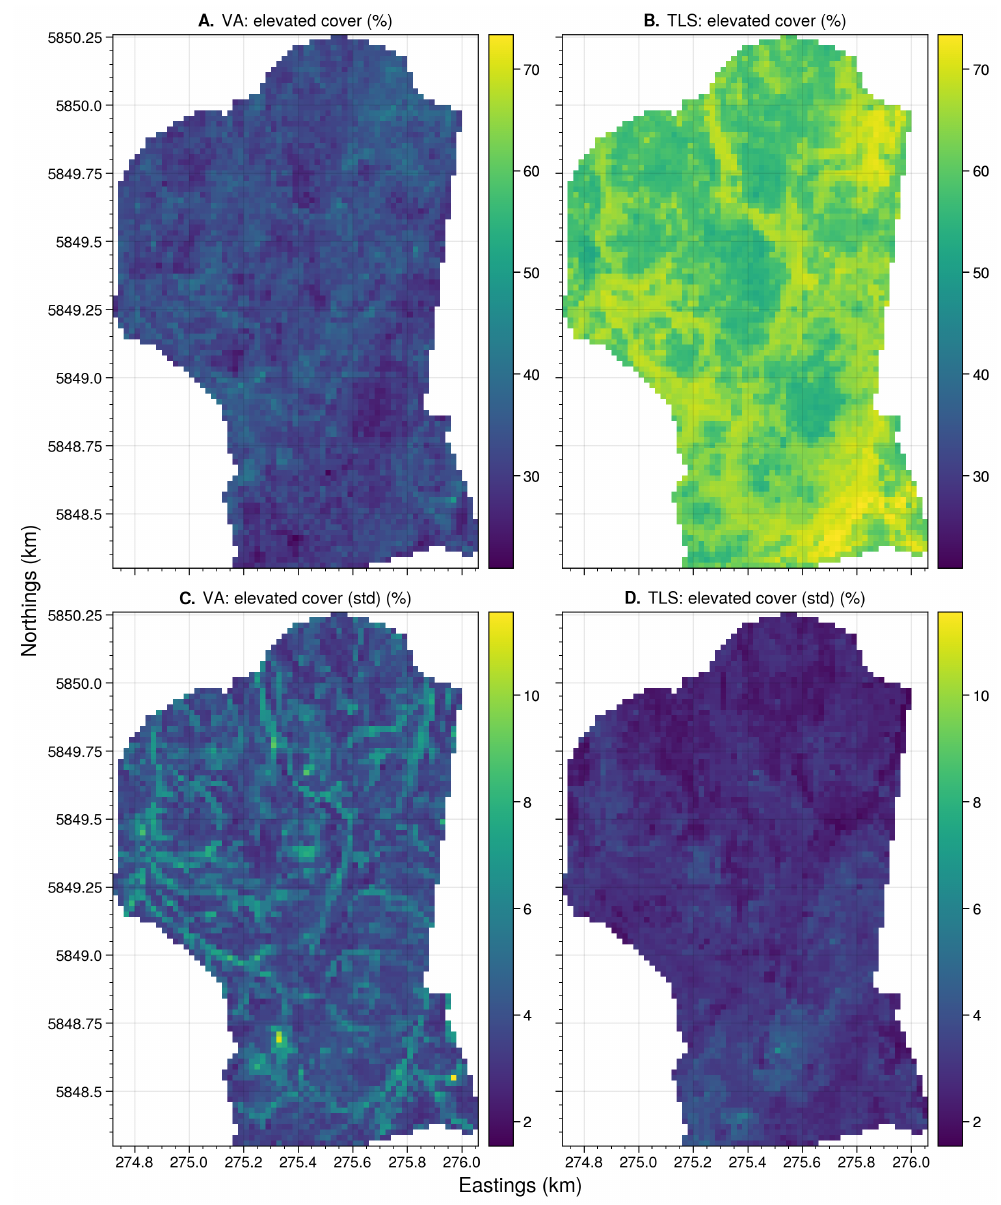
Figure A5. The mean and standard deviation of landscape-level predictions for elevated fuel cover using visual assessments ( A , C ) and TLS ( B , D ) at